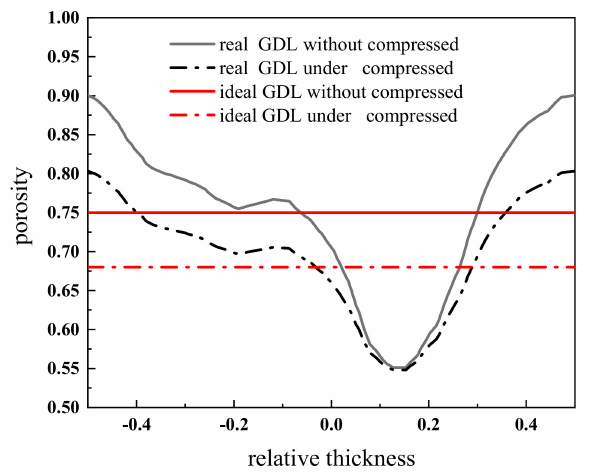
Figure 1. The change of porosity in the thickness direction of the GDL before and after